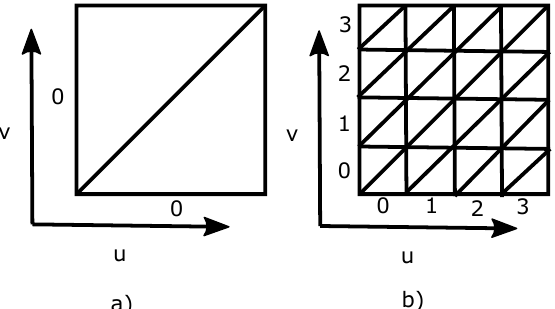
Figure 9. (a) Connectivity maps can be assigned to two adjacent triangles to form a quadrilateral domain parameterized by u and v ranging from 0 to 1. (b) Applying traditional 1:4 refinement twice on a triangular connectivity map produces small quad domains within the connectivity map that can be indexed by parameters u and v .